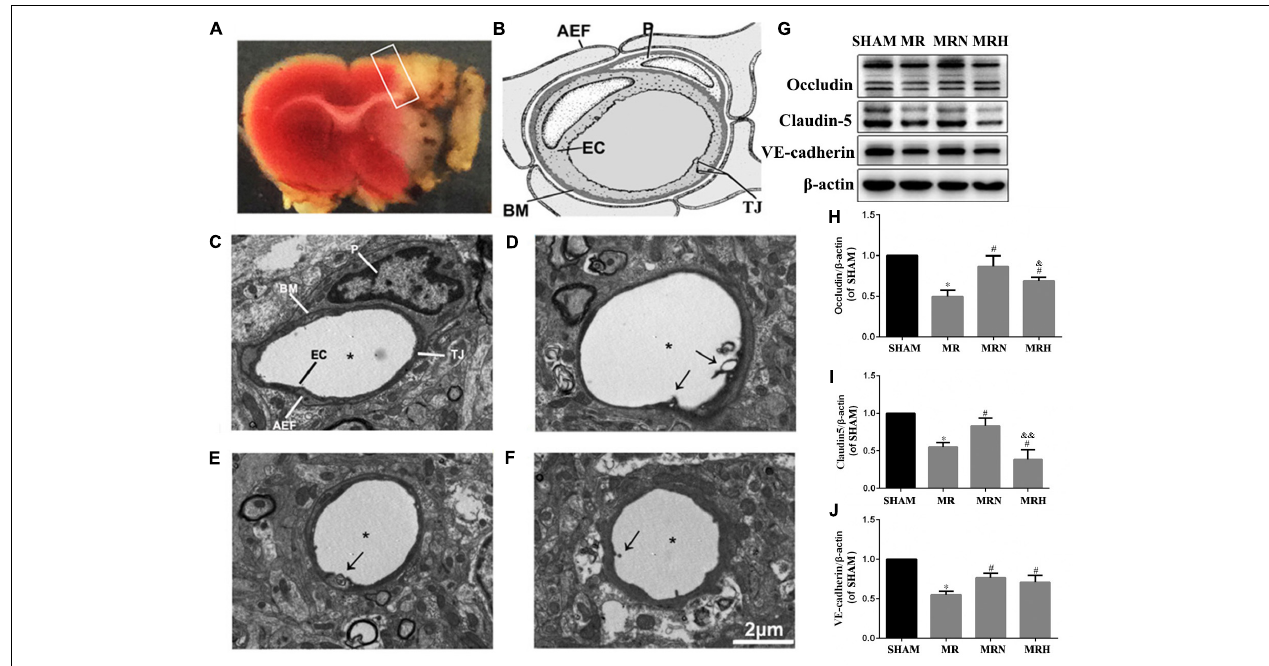
FIGURE 3 | Rosuvastatin upregulated the levels of TJs and AJs in the peri-infarct region following reperfusion. (A) Representative coronal sections stained by TTC following MCAO and after 24 h reperfusion. The white color indicates the infarct region, which was observed as a pale color with the naked eye, and the white box indicates the peri-infarct region being observed. (B) General view of neurovascular unit is presented; P indicates pericyte, EC indicates endothelial cell, AEF indicates astrocytic end-feet, TJ indicates tight junction. The images were visualized using TEM at a magnification of 6000 × (scale bar = 2 µ m). (C) Transmission electron micrographs show the normal ultrastructure of the BBB in the cerebral peri-infarct area, which is labeled similarly to the general view of a neurovascular unit seen in (B) . (D) Transmission electron micrographs show the abnormal ultrastructure of the BBB in the cerebral peri-infarct area of MR mice. Stars indicate the microvessel lumen, and arrows indicate broken TJs. (E,F) show the abnormal ultrastructure of the BBB in the cerebral peri-infarct areas of MRN and MRH mice under TEM, respectively. Stars indicate the microvessel lumen, and the arrows indicated broken TJs. (G) The bands for the occludin, claudin-5, VE-cadherin, and β -actin proteins were detected by Western blotting. (H–J) The relative densities were assessed by calculating the ratios of the occludin, claudin-5 and VE-cadherin proteins to β -actin and compared with those of the SHAM group ( ∗ P < 0.05), among the MRN, MRH, and MR groups ( # P < 0.05), and between the MRN and MRH groups ( & P < 0.05, && P < 0.01). Means ± SEM, n =